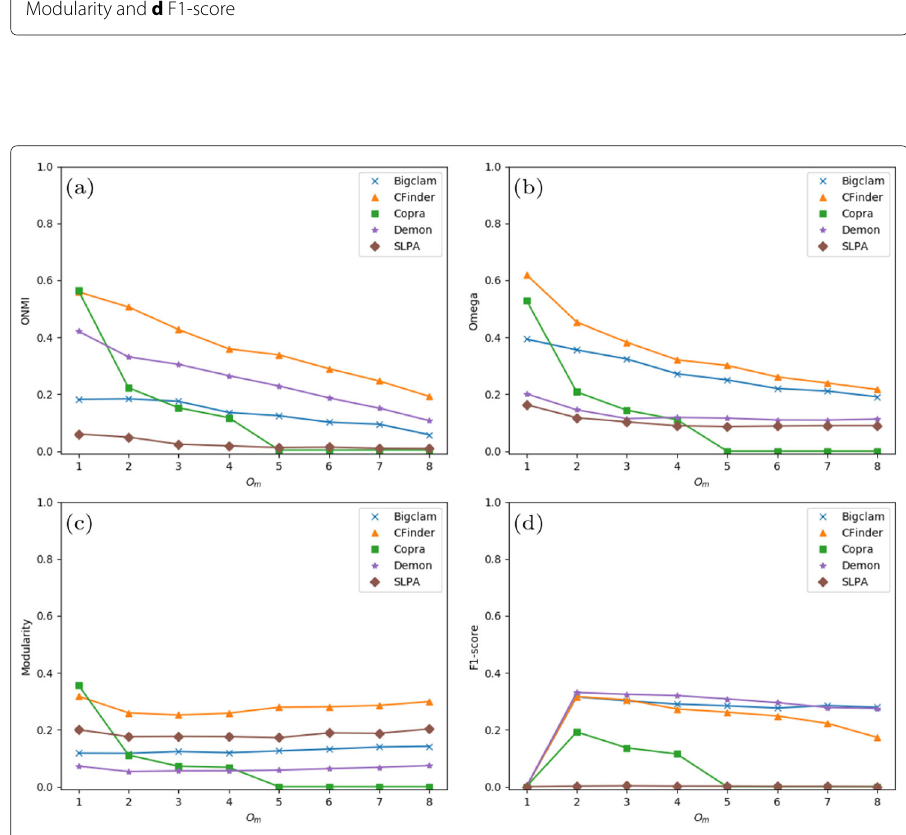
Fig. 10 Variation of the maximum number of memberships ( O m ) for LFR synthetic networks considering: a ONMI; b Omega; c Modularity and d